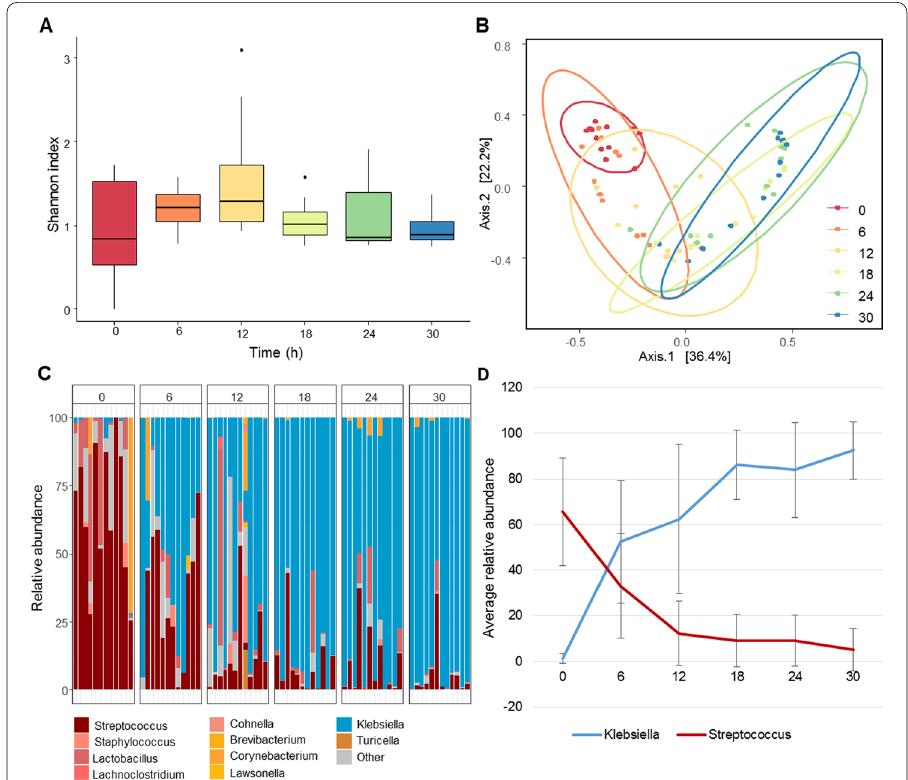
Fig. 2 Lung microbiota dynamics after inoculation with 1 10 4 CFU of K. pneumoniae . Samples were × analyzed at time is 0, 6, 12, 18, 24 and 30 h, with n 12 mice. a Shannon index for alpha diversity. b Principal = coordinates analysis (PCoA) of Bray–Curtis dissimilarities of the lung microbiota. c Relative abundances of top 10 most abundant genera. d The most prevalent genera Streptococcus and Klebsiella have been plotted with their relative abundances and standard deviations over